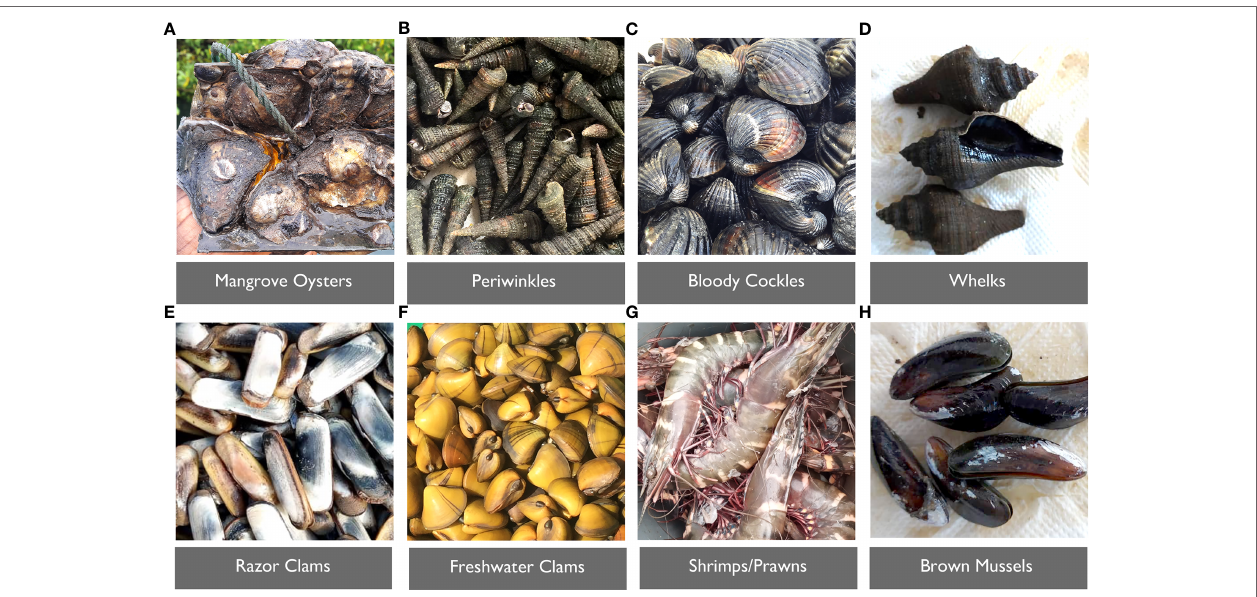
FIGURE 5 | Common shellfish species harvested along the coast of West Africa; left to right on top row— (A) The West African mangrove oyster ( Crassostrea tulipa ), (B) periwinkles ( Tympanotonus fuscatus ), (C) bloody cockle ( Senilia senilis ), and (D) whelks ( Pugilina morio ). Left to right on bottom row— (E) razor clams ( Tagelus adansonii ), (F) freshwater/Volta clam ( Galatea paradoxa ), (G) shrimps (Penaeids), and the (H) brown mussel ( Perna perna ). [Data source: All images captured by authors for this study].